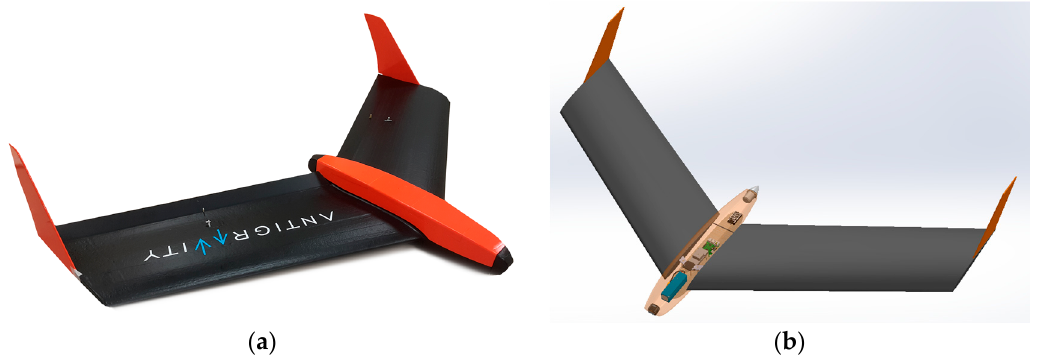
Figure 8. Research UAV: ( a ) Manufactured UAV; ( b ) UAV prototype in “Solidworks”.